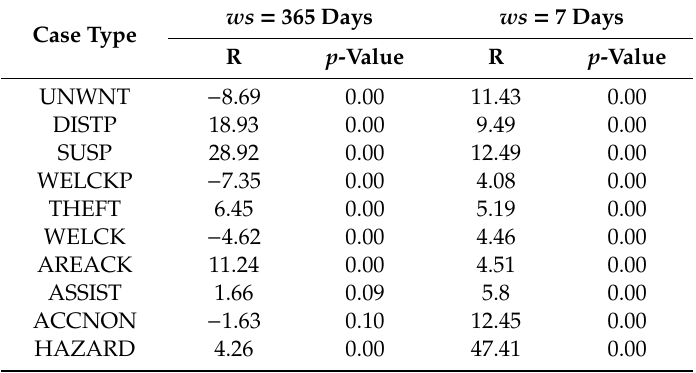
Table 7. Distribution autocorrelation of human activity events (DAE) of call for service